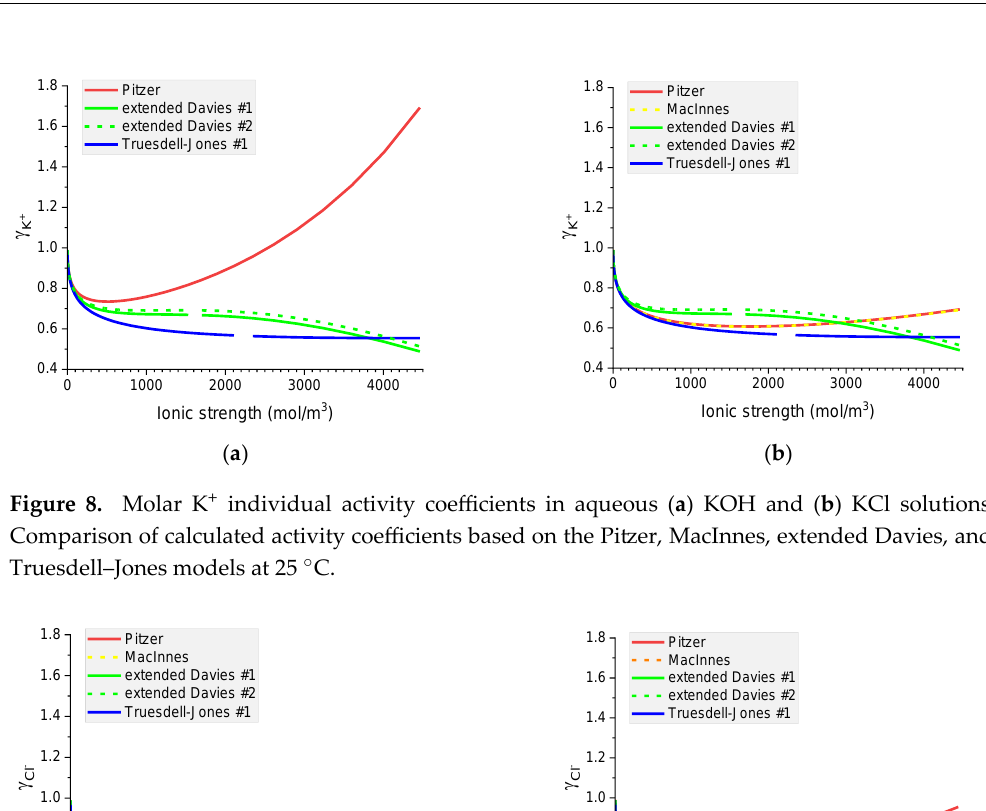
Figure 7. Molar OH − individual activity coefficients in aqueous ( a ) NaOH and ( b ) KOH solutions. Comparison of calculated activity coefficients based on the Pitzer, extended Davies, and Truesdell – Jones models at 25 °C.